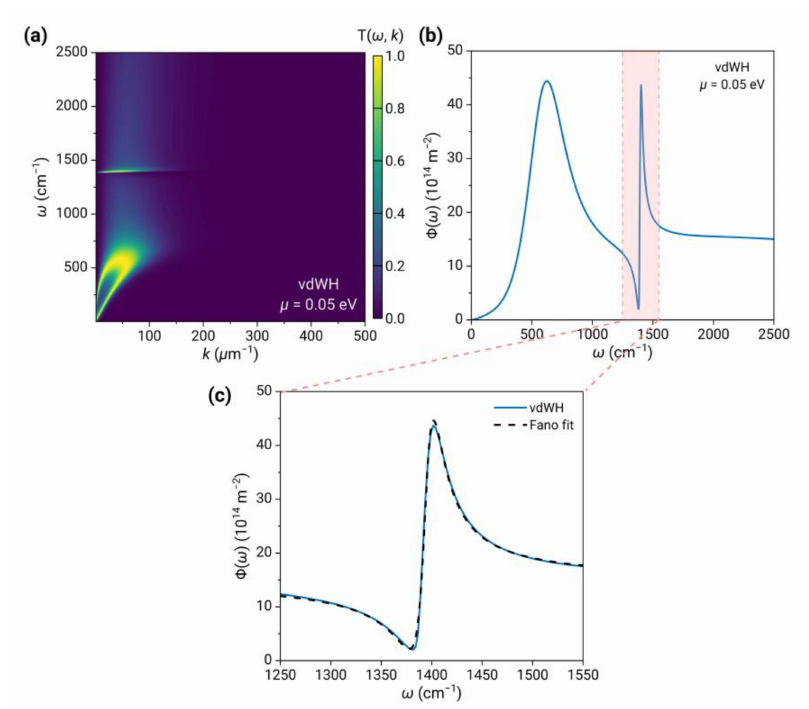
Figure 3. ( a , b ) The energy transmission coefficient T ( ω , k ; d ) and energy transfer function Φ ( ω ) between two 2D vdW heterostructure sheets at temperatures of 290 K and 300 K. The distance is 10 nm, and the chemical potential of graphene is 0.05 eV. ( c ) The zoom-in view of Φ ( ω ) on the shaded region in ( b ) and the fitting using the Fano formula.